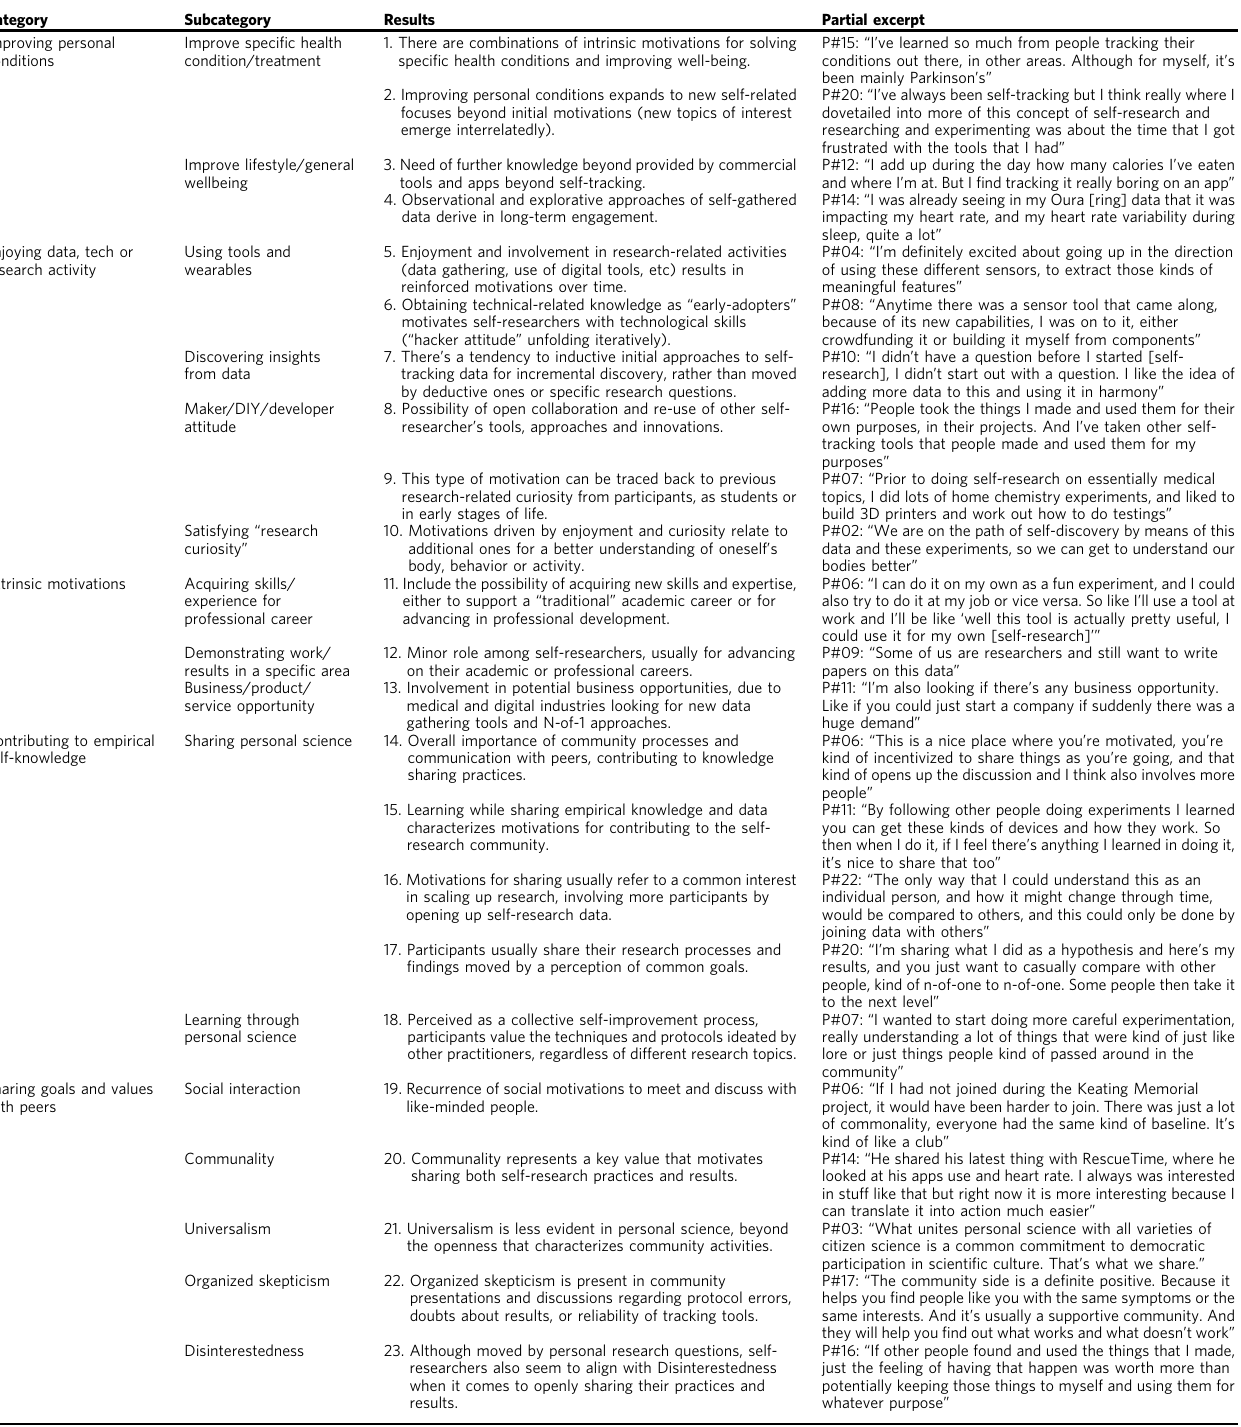
Table 2 Summary of the main fi ndings across the different categories as de fi ned in the codebook.